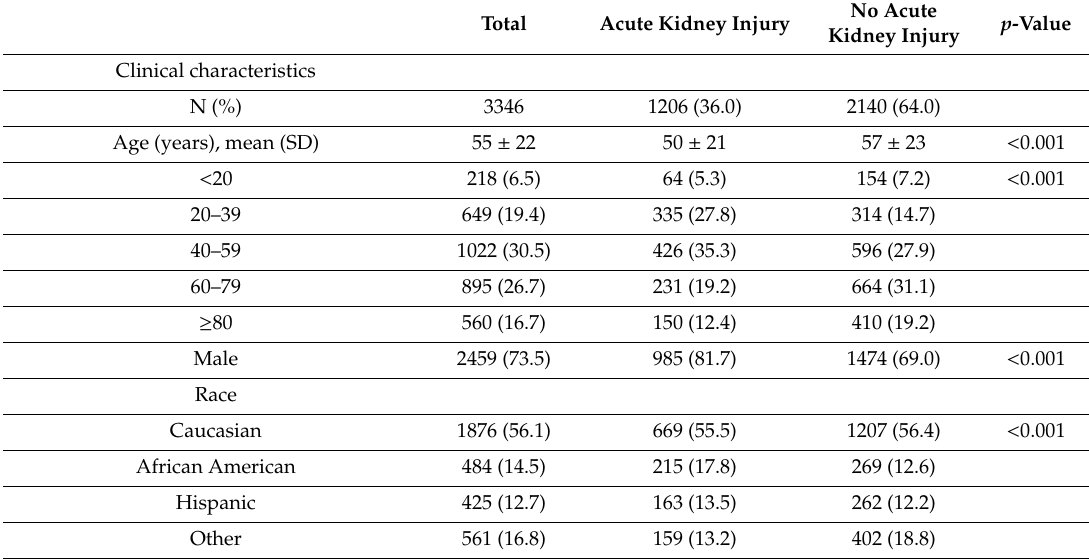
Table 1. Clinical characteristics, in-hospital treatments, complications, outcomes, and resource utilization in heat stroke patients with and without acute kidney